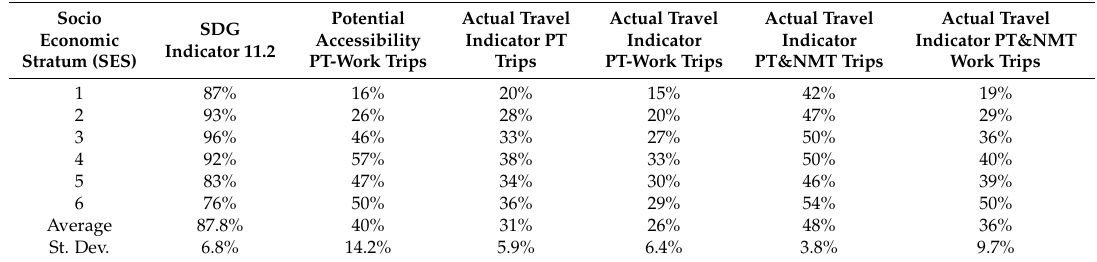
Table 4. Quantification of all indicators per socio-economic